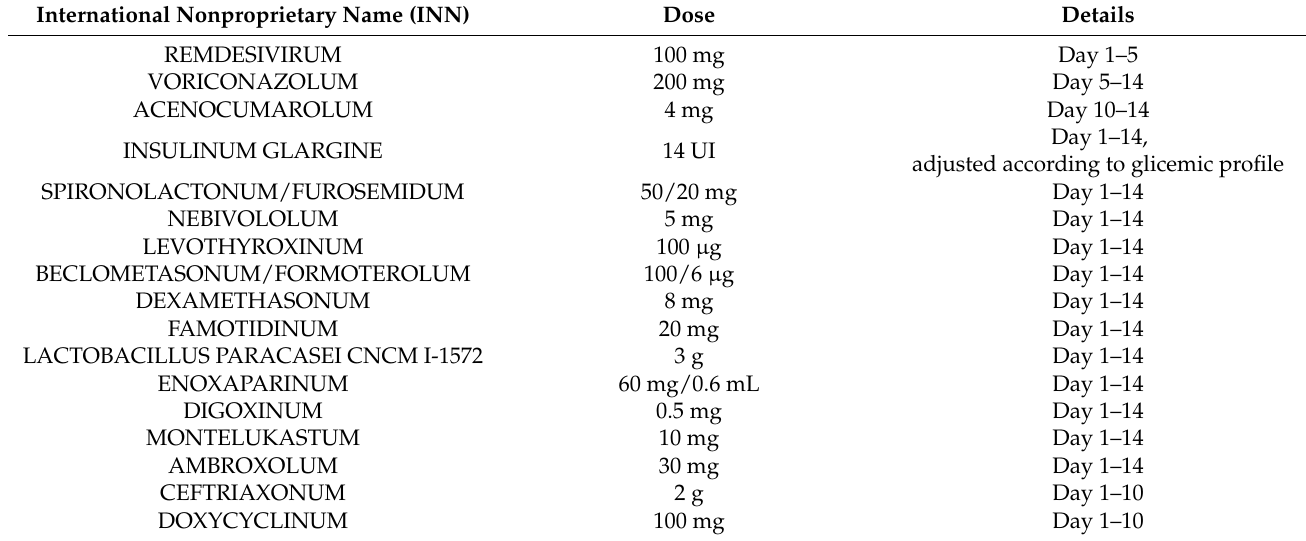
Table 1. Medication used for the